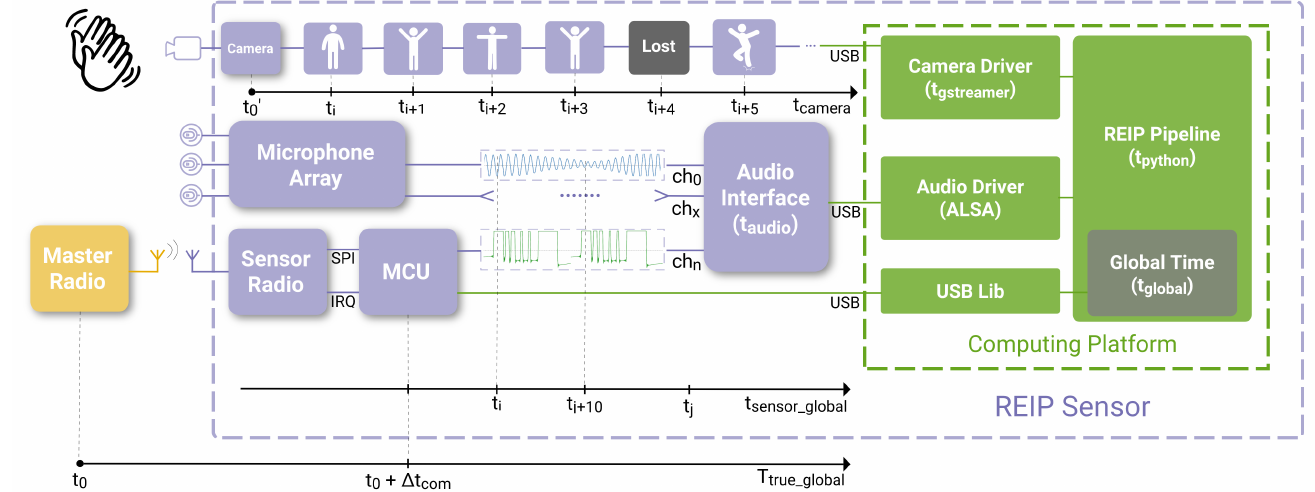
Figure 5. Multimodal synchronization workflow. Each sensor is receiving the global timestamps from a master radio (at 1200 Hz) and is embedding every 10th of them in a serialized form as an extra audio track synchronous with the microphone array data. For the cameras used in REIP sensors, it is not possible to embed the timing information directly into the video data itself. Instead, the timestamps provided by the camera driver are converted into the global timeline using the computing platform that is continuously updating the latest timestamp received by the microcontroller unit (MCU) via USB. More details on video synchronization can be found in Section 3.3.2. The camera’s time axis is compressed by about an order of magnitude for illustration